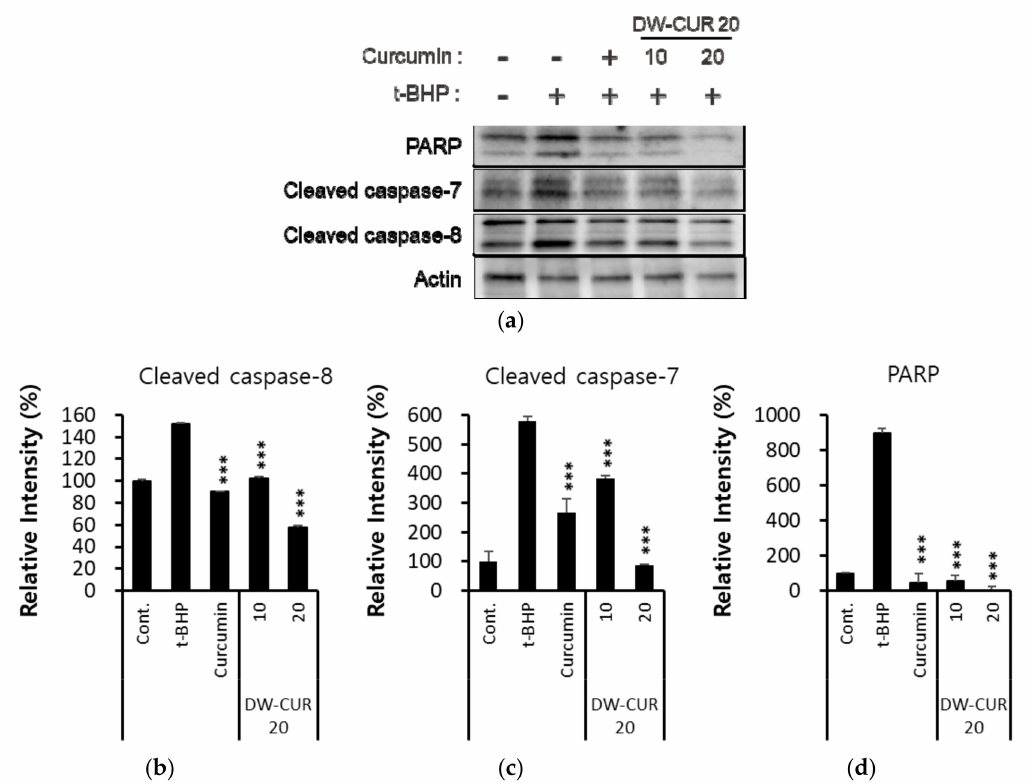
Figure 6. E ff ects of DW-CUR 20 on cleavage of caspases-7, -8 and PARP in HepG2 cells. Curcumin (4 µ g / mL) was used as a positive control. Whole cell lysates were separated by electrophoresis, transferred onto membranes, and probed with the indicated antibodies. Cleaved caspase-7, -8 and PARP were detected using specific primary antibodies. β -Actin served as an internal loading control. All immunoblot bands were obtained from the same cell lysates ( a ). The bar charts display the intensity of Cleaved caspase-7, -8 or PARP after being normalized by β -Actin using ImageJ software ( b – d ). Data are presented as the means ± SD of three independent experiments. *** p < 0.001 vs the t-BHP treatment